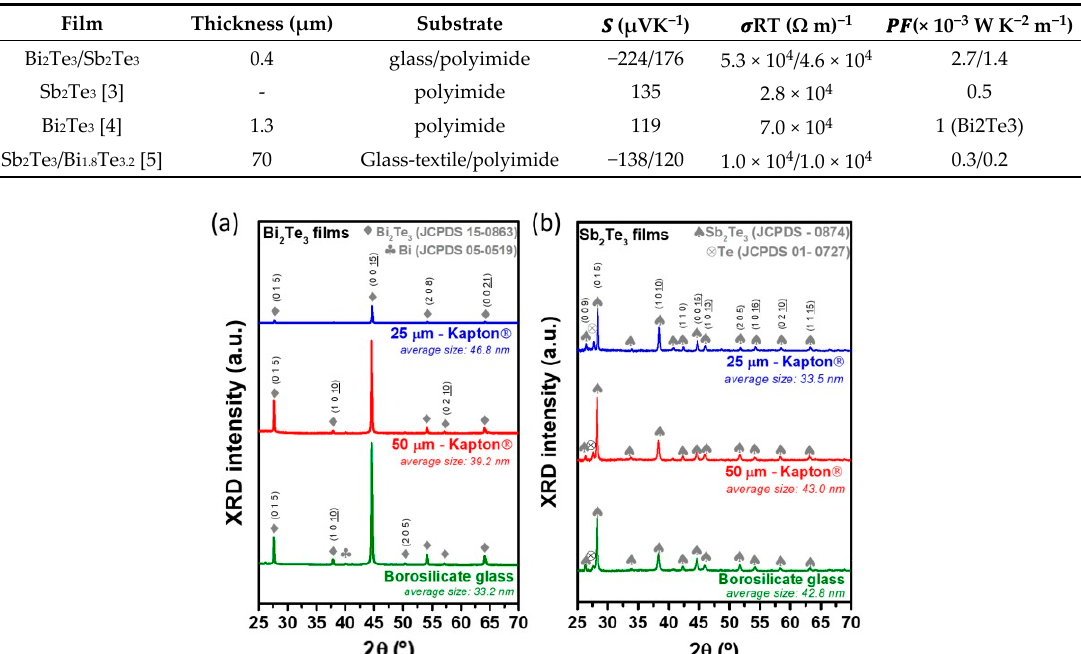
Table 1. Comparison of TE properties of the Bi 2 Te 3 and Sb 2 Te 3 in the present study with other reported by other authors (with different techniques).